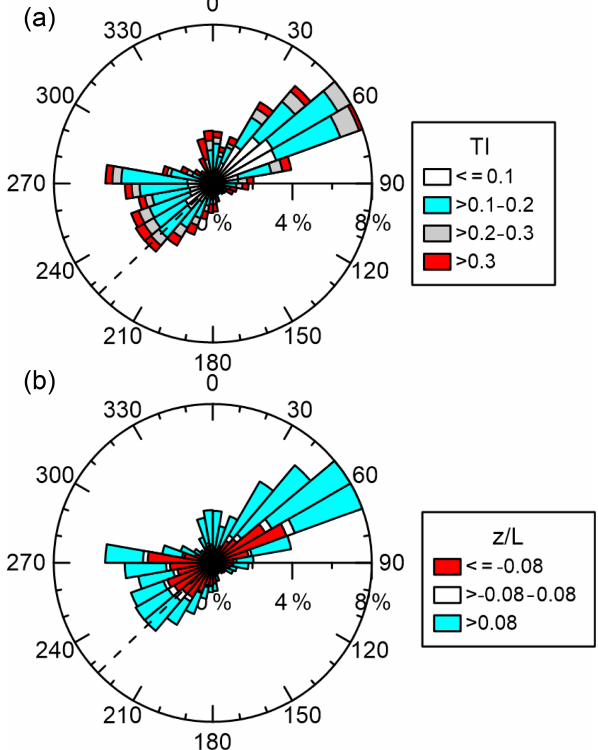
Figure 9. Top: turbulence intensity rose from 78m height at Tower 20 (location shown Fig. 1) for March–June 2017. Coloured bars show the turbulence intensity defined from Eq. (12). Bottom: atmo- spheric stability rose from 78m height at Tower 20 (location shown Fig. 1) for March–June 2018. Coloured bars show the value of z/L ( L is defined from Eq. 4), where white is near neutral, red is un- stable and cyan is stable. The wake centre line direction of 227 ◦ is marked with the black dashed